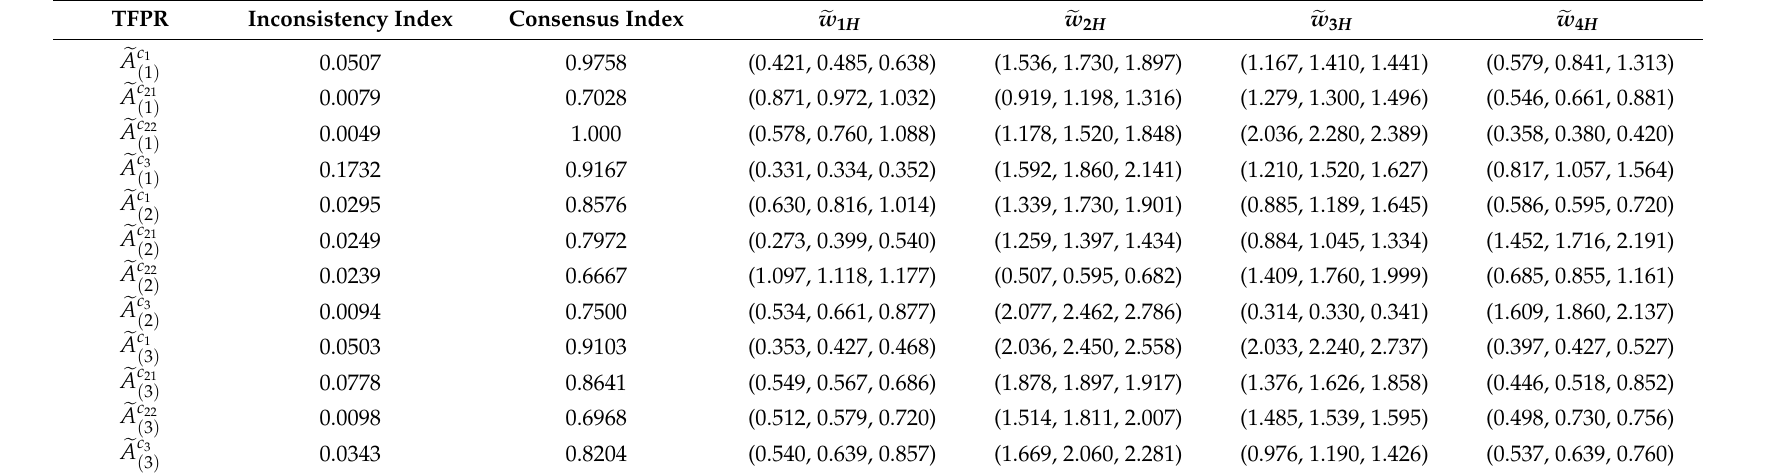
Table 5. Inconsistency and consensus indices as well as triangular fuzzy